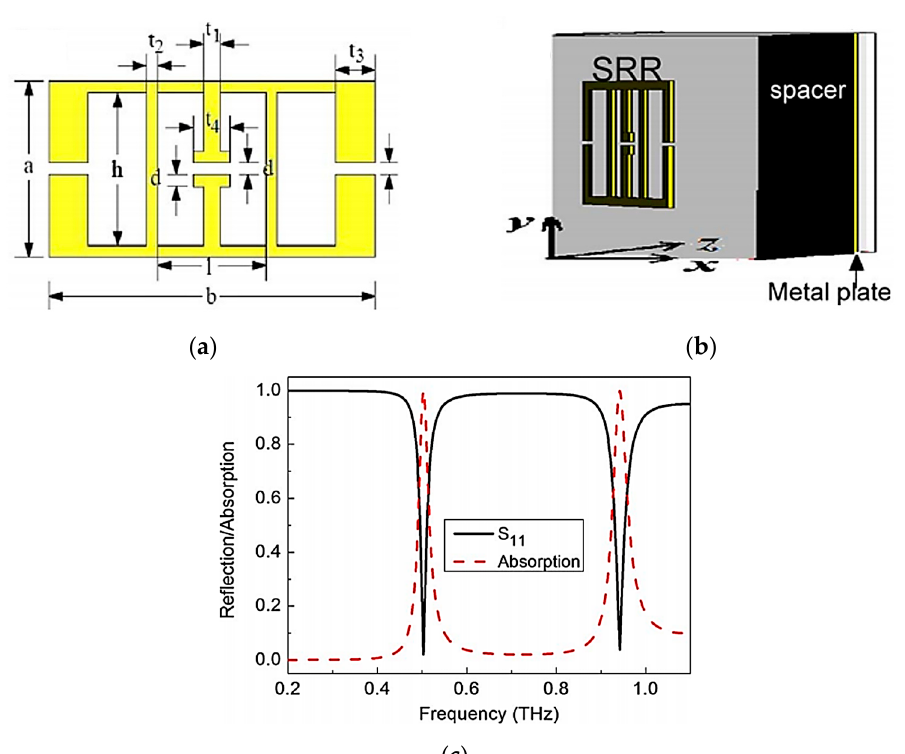
Figure 9. Dual frequency terahertz metamaterial absorber. ( a ) Top view; ( b ) the main view; ( c ) reflection and absorption curves [47].